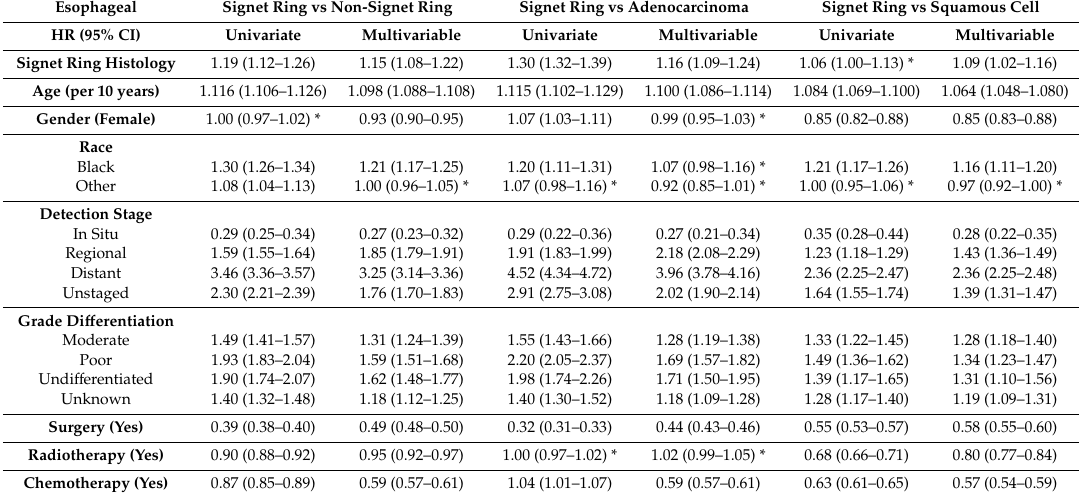
Table 6. Derived univariate and multivariable Cox-proportional hazard ratios (HR) of mortality for esophageal cancers.